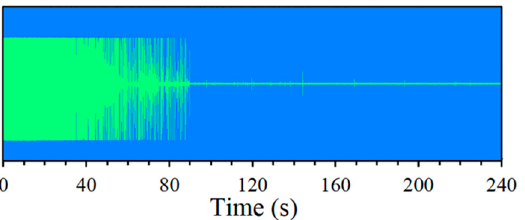
Figure 8. Record of the complete AE signal for bearing steel from isothermal quenching at a temperature of 150 °C.